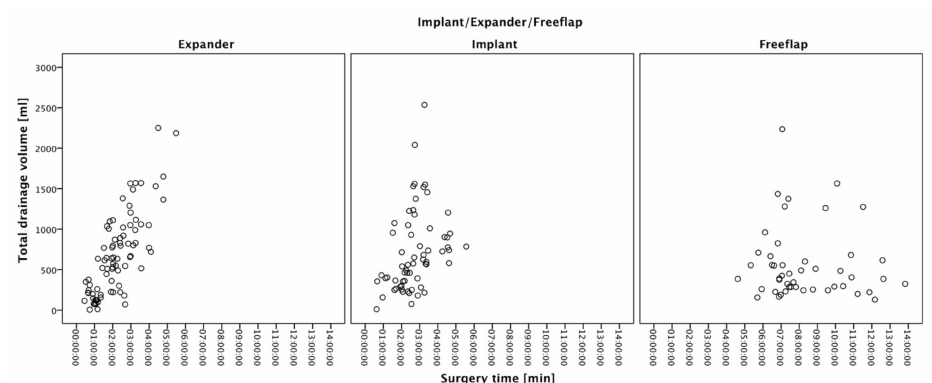
Figure 2. Scatter plot correlation of postoperative drainage fluid and surgery duration: overall, no significant correlation between total drainage output and surgery time was seen in our groups ( τ b = 0.187; p < 0.0001). However, patients reconstructed with tissue expander or definitive breast implants showed a significant correlation between higher drainage output and surgery time (tissue expander: τ b = 0.553, p < 0.0001; definitive implants: τ b = 0.337, p < 0.0001).